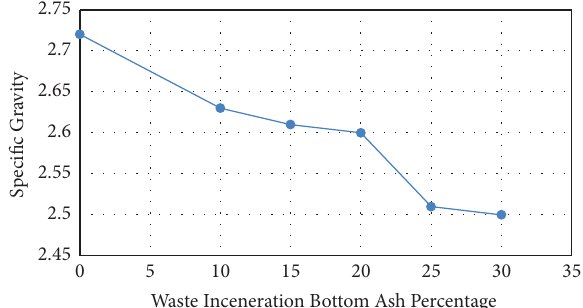
Figure 2: Efect of waste incineration bottom ash on specifc gravity of soil.